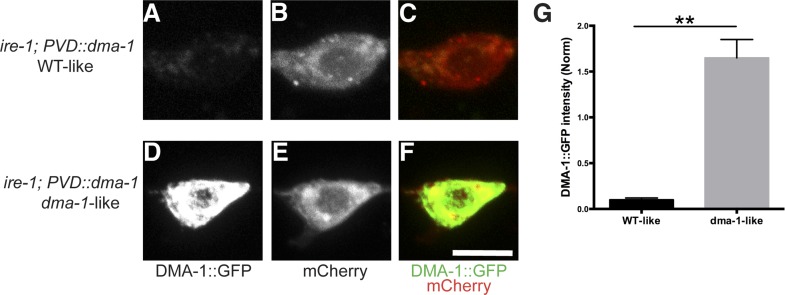
Accumulation or aggregation of DMA-1::GFP in the PVD cell bodies is tightly correlated PVD dendrite morphology.In the same trangene (wyEx7338) bearing dma-1::GFP expression in ire-1 mutants, there is much less accumulation or aggregation of DMA-1::GFP in the PVD cell bodies with the rescued ‘WT-like’ PVD morphology (A to C) compared with more severely defective ‘dma-1 like’ animals (D to F). (G) Quantification of the DMA-1::GFP intensity in the cell bodies (normalized to cytoplasmic mCherry) in (A to F). Error bars show mean ± s.e.m. n = 20. **p < 0.01, t-test. Scale bar, 5 μm.